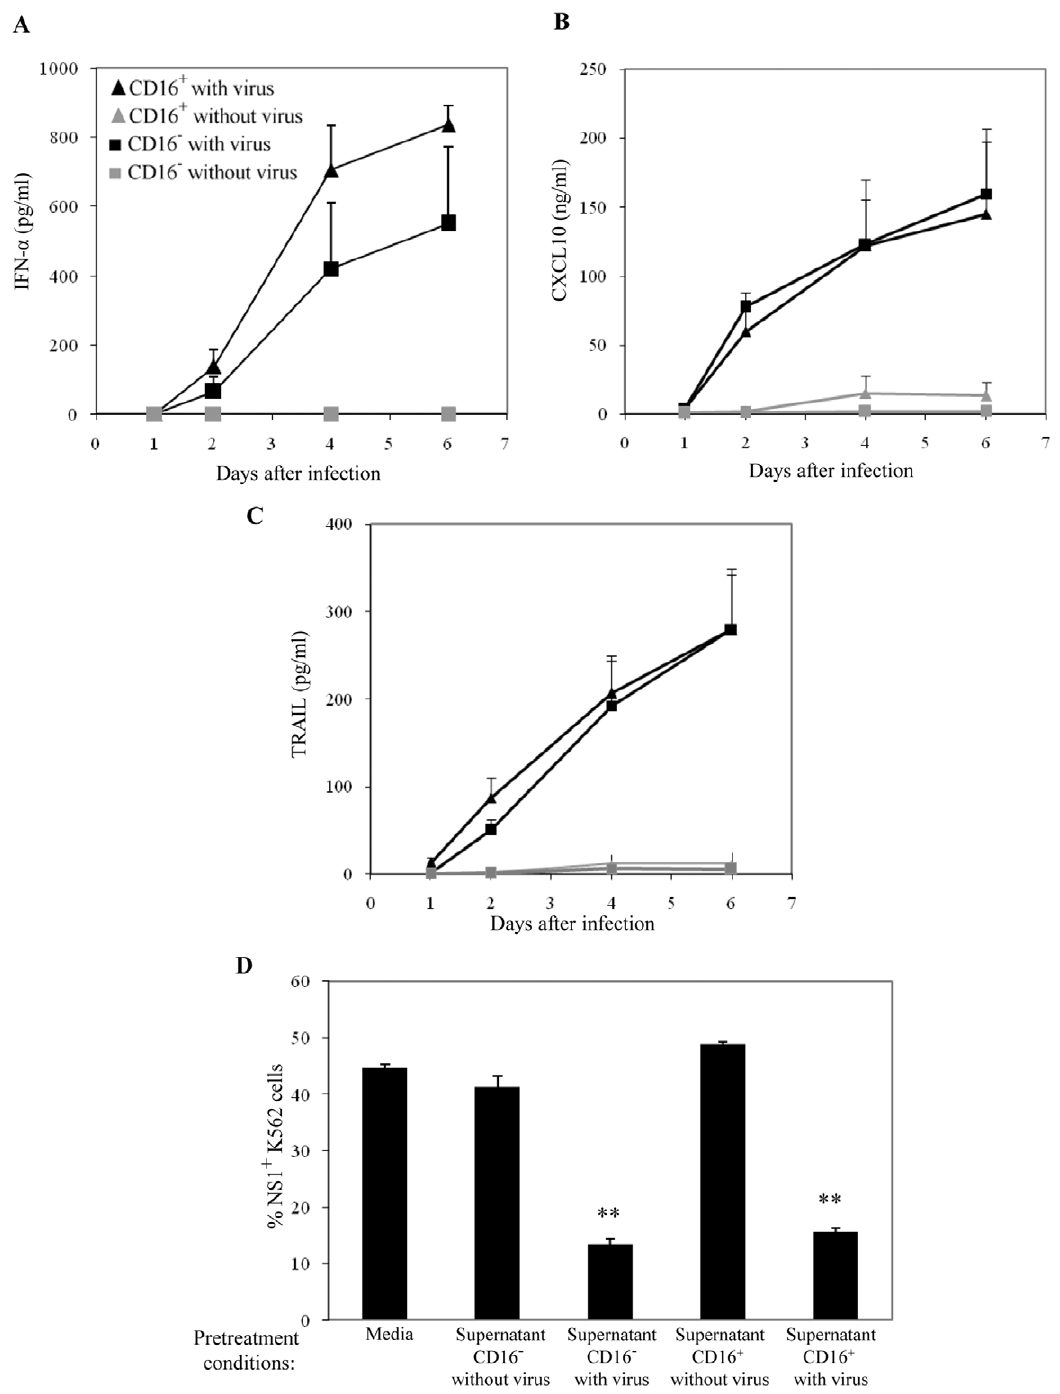
Figure 2. Production of soluble factors associated with protection against dengue by monocyte subsets. Isolated monocyte subsets were either exposed to dengue virus (DENV2, NGC) at a MOI of 10 or medium without virus. Supernatants were harvested over the course of 6 days. (A) Levels of IFN- a were determined by a multi-subtype specific ELISA kit. (B and C) Levels of CXCL10 and TRAIL were determined using multiplex bead arrays. Results are mean 6 SE for 6 different donors. There were no significant differences were found between infected CD16 2 and CD16 + monocytes. (D) Supernatants from CD16 2 and CD16 + monocytes exposed to dengue virus or medium without virus were harvested at day 6. These supernatants were passed through 100 kDa centrifuge filters to remove dengue virus. K562 cells were pretreated for 24 hours with either culture medium, supernatants of CD16 2 or CD16 + monocytes with or without virus exposure. Pre-treated K562 cells were washed and infected with dengue virus at a MOI of 2. After 2 days, the extent of infection was determined by intracellular labeling of K562 cells with anti-NS1 antibody. The percentage of NS1 + K562 cells after 2 days is shown. Data are representative of 2 experiments using different donors. **, p , 0.005 between respective monocyte subset with and without virus.